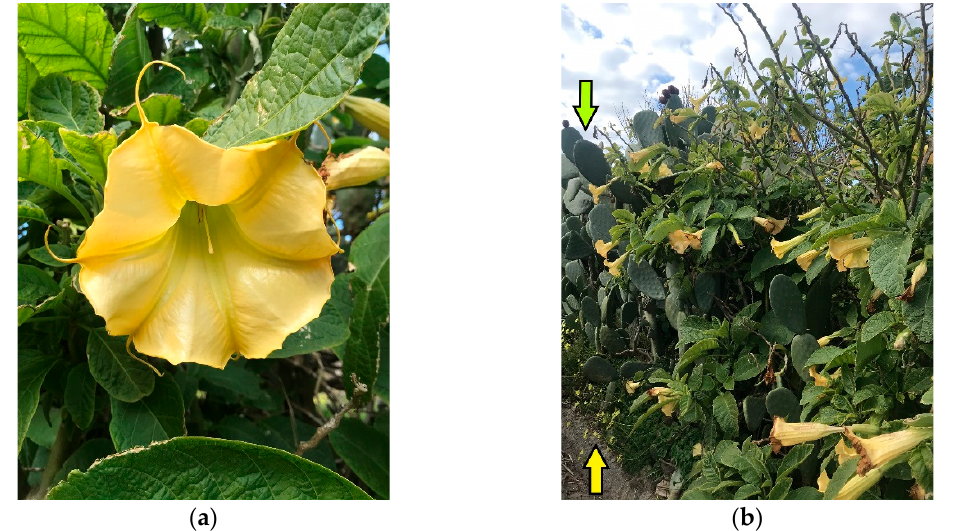
Figure A2. Brugmansia aurea Lagerh. found in a roadside in Brancaleone (Reggio Calabria province): ( a ) flower; ( b ) several individuals of B. aurea mixed with Oxalis pes-caprae L. (yellow arrow) and Opuntia ficus-indica (L.) Mill. (green arrow) (Photographs VLA Laface).